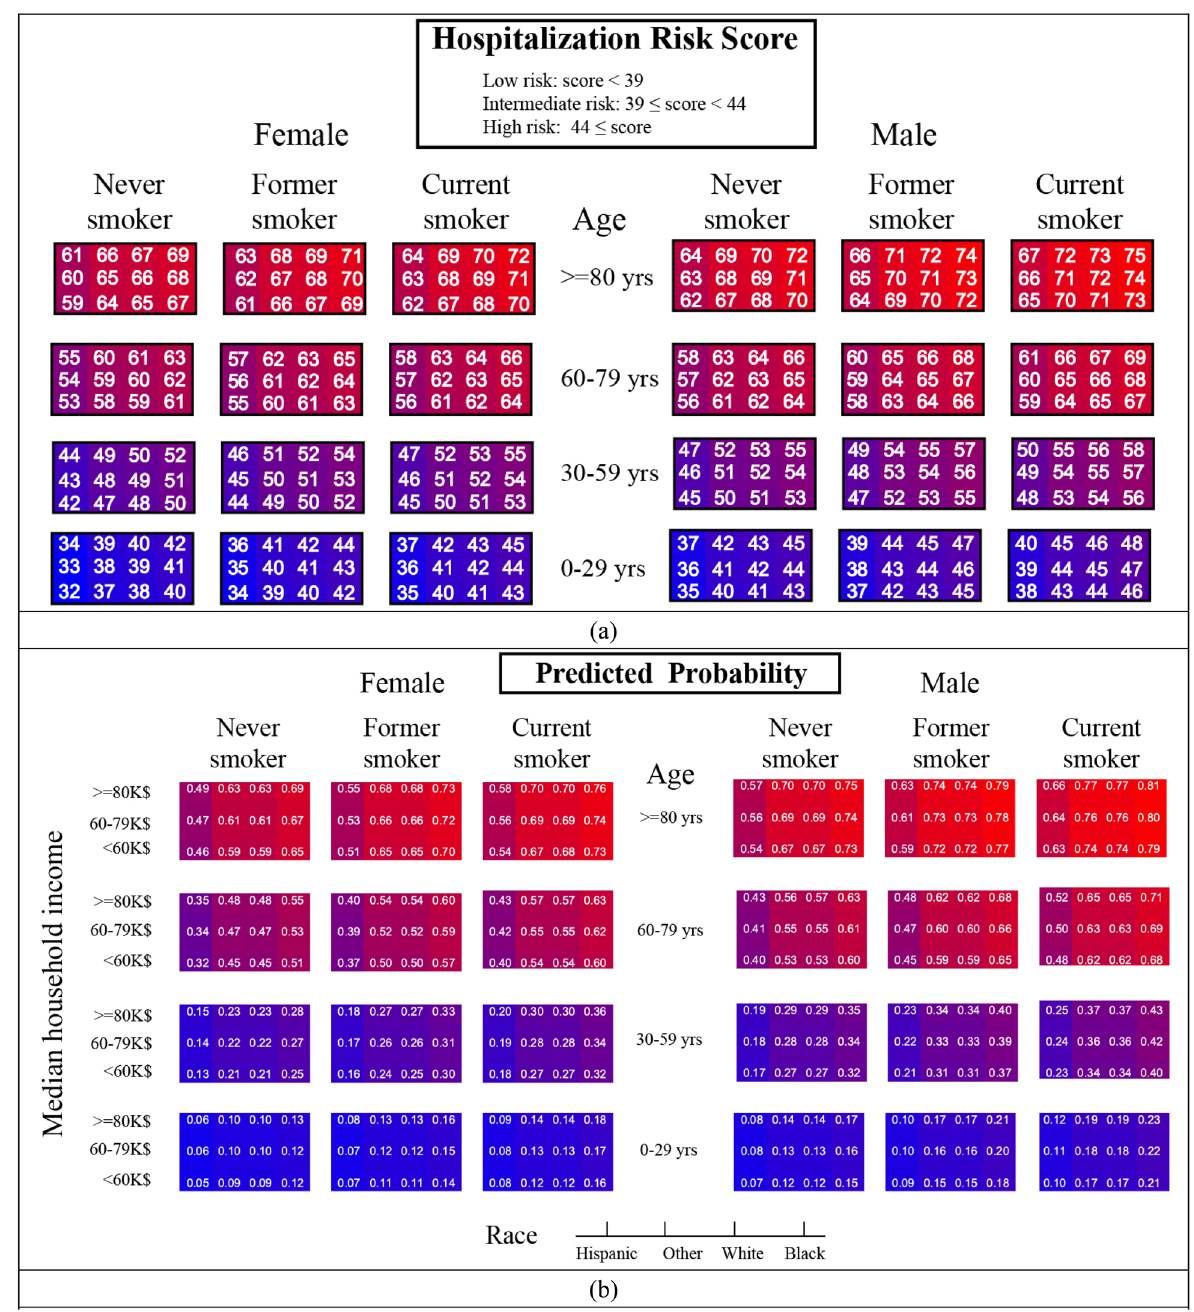
Figure 1. SARS2 scores heatmap for risk of hospitalization. ( a ) Scaled risk scores are divided into female patients (left panel) and male patients (right panel). The columns in each panel represent different smoking status. Every row indicates an age category. Each matrix shows the three median household incomes in rows, and columns of these matrices indicate four race/ethnic groups. The cells are colored from light-blue (lowest score: 0) to dark red (highest score: 68). The top panel indicates score ranges corresponding to low, intermediate, and high-risk groups. ( b ) Predicted risk probabilities. According to the US Census 2018, the lower median income cutoff ($60 K) represents the lower 62% of the population, and the high-income cutoff ($80 K) represents the top 15% of the